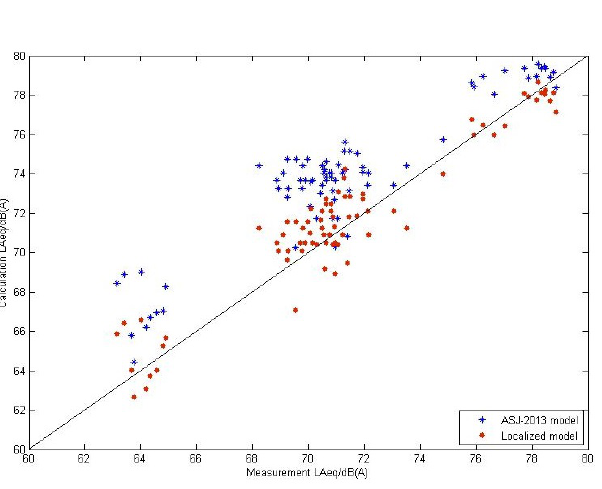
Figure 2: Comparison between prediction results and experimental